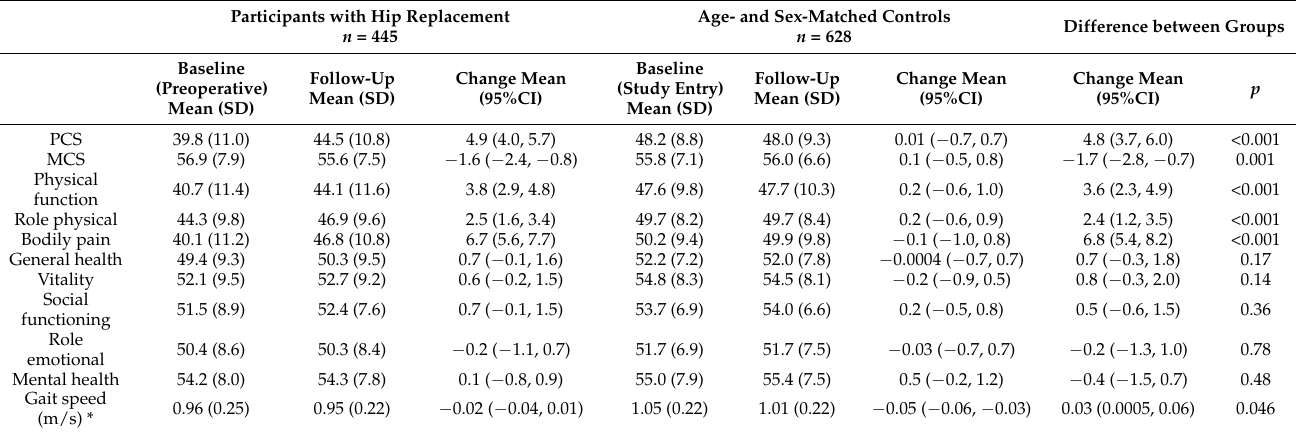
Table 2. Baseline and follow-up measures of health status and gait speed in participants with hip replacement and age- and sex-matched